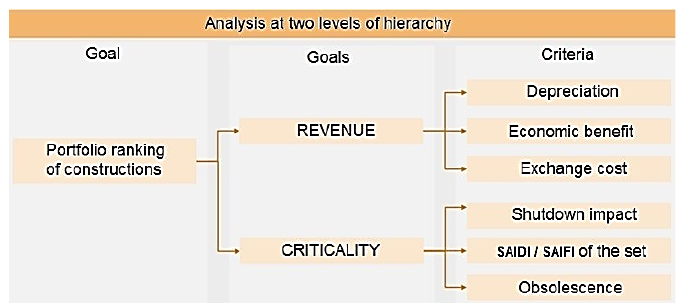
Figure 5. Hierarchical decision tree for this work [authors].